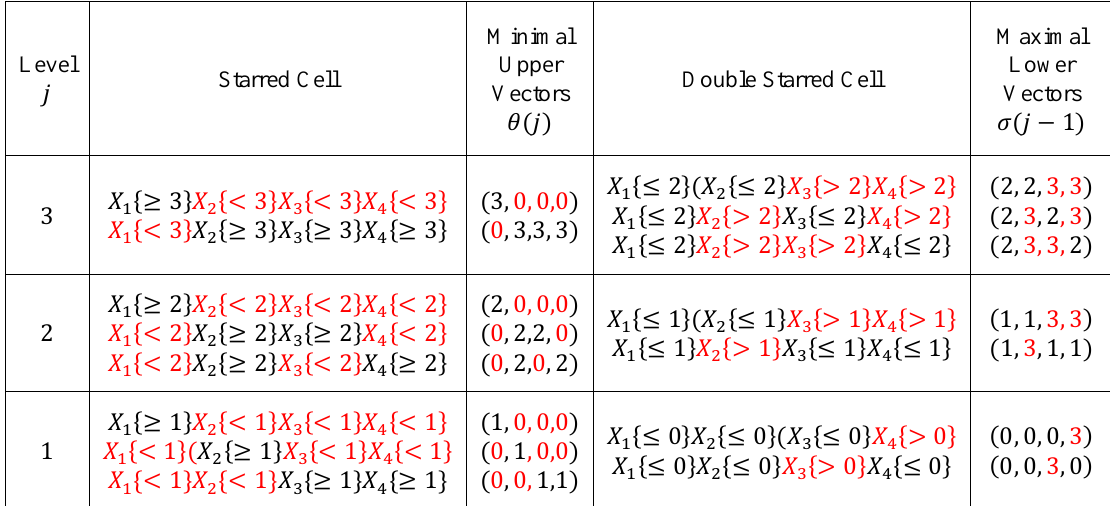
Table 2. Using minimality of an extreme (starred) cell of a prime implicant of success at level 𝑗 to produce a minimal upper vector, and using maximality of an extreme (double-starred) cell of a prime implicant of failure at level 𝑗 to produce a maximal lower vector. Since the system is binary-imaged, elements of the MUVs set 𝜃(𝑗) belong to {0, 𝑗} , while elements of the MLVs set 𝜎(𝑗) belong to { 𝑗, 𝑚} . Minimal Level Upper Starred Cell Double Starred Cell Vectors 𝑗 𝜃(𝑗)